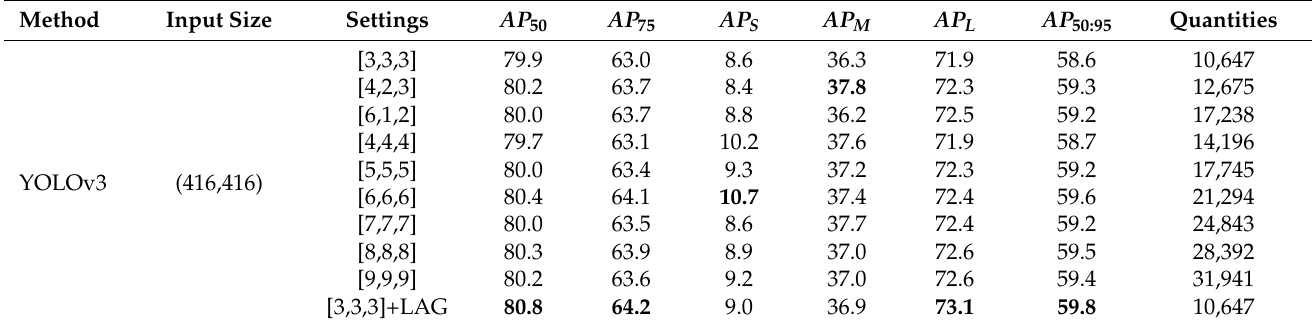
Table 4. Experiment results under different anchor strategies on the DIOR